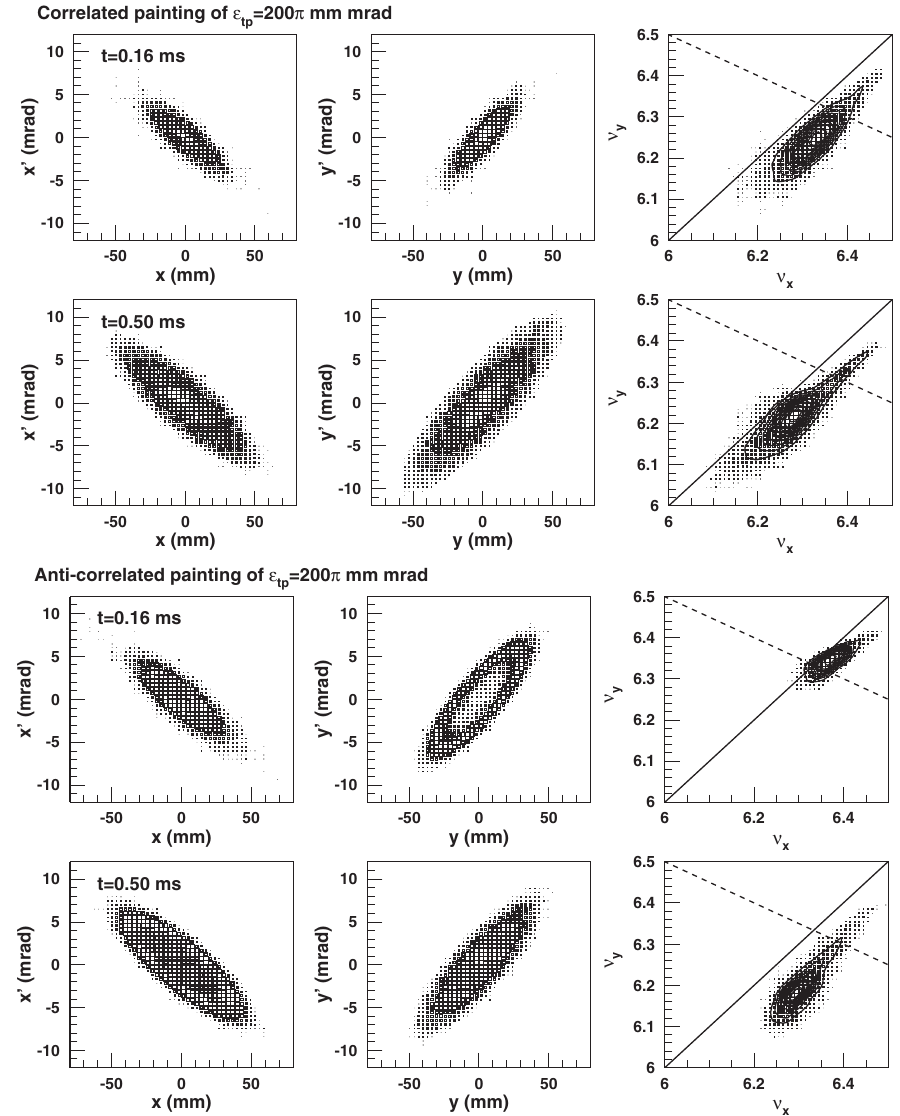
FIG. 35. Transverse phase space coordinates and tune footprints at 0.16 ms (the first one-third of injection) and 0.5 ms (the end of injection) calculated for the beam intensity of 1 MW with correlated (upper) and anticorrelated (lower) painting of ϵ 200 π mm tp ¼